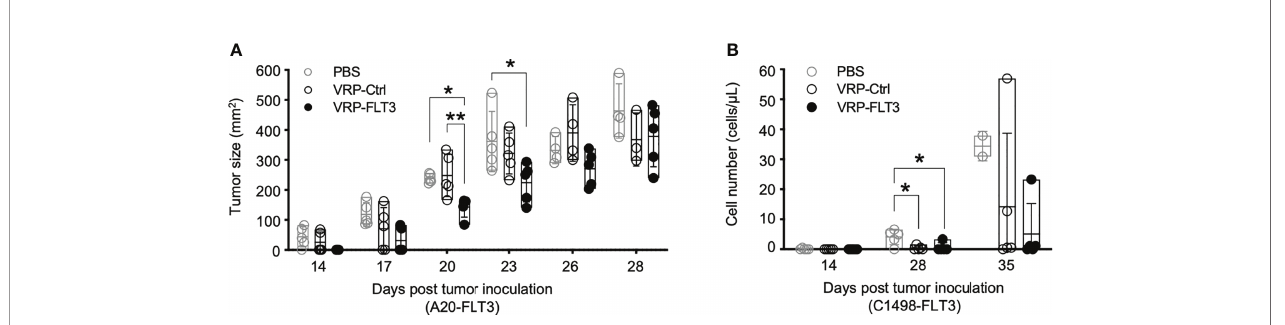
FIGURE 7 | VRP vaccination attenuates the growth of FLT3-expressing A20 tumor cells and FLT3-expressing C1498 tumor cells. (A) Mice challenged with A20- FLT3 tumor cells were vaccinated as described in Figure 1 . Tumor area of individual mice are depicted (n=5 per group). Lines represent the mean value of each groups. Statistical signi fi cance was determined by one-way ANOVA, *P<0.05, **P<0.01. (B) Inoculation of FLT3-expressing C1498 tumor cells and the vaccination schedule are as described in Figure 1 . C1498-FLT3 tumor cells in peripheral blood were determined by Flow cytometry. Each symbol represents an individual mouse (n=5 per group). Bars represent the mean ± SD. Statistical signi fi cance was determined by one-way